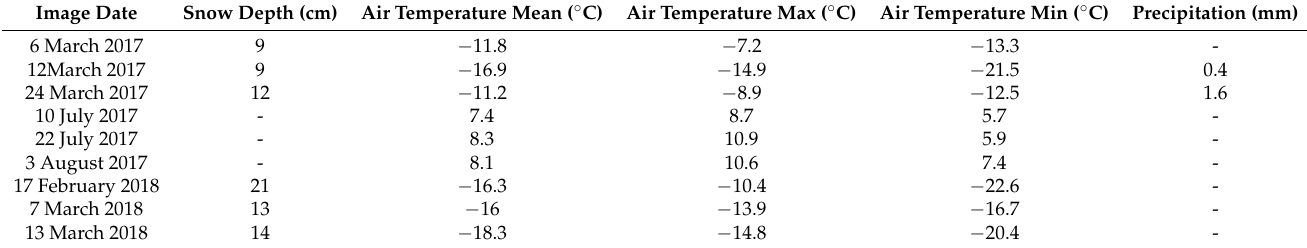
Table 2. Sentinel-1 master images and meteorological data years